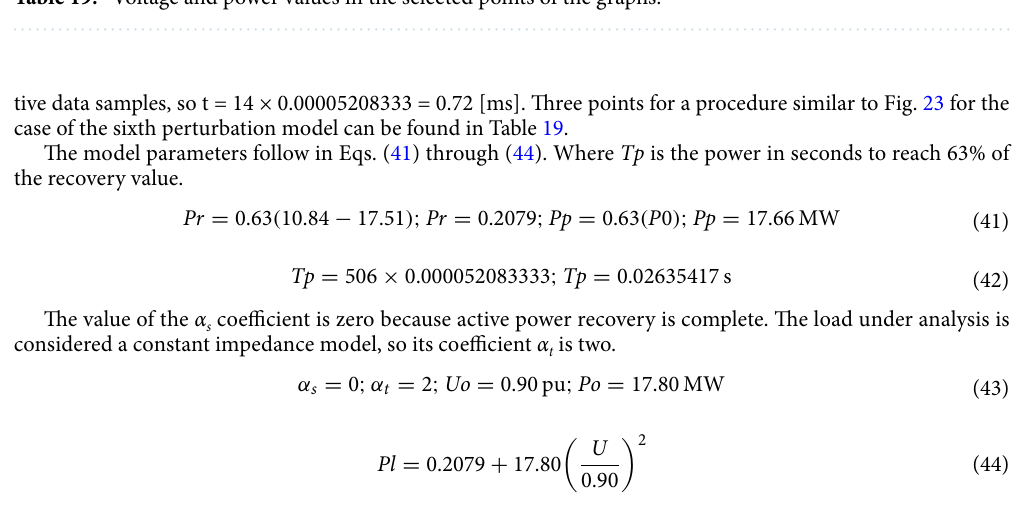
Table 19. Voltage and power values in the selected points of the